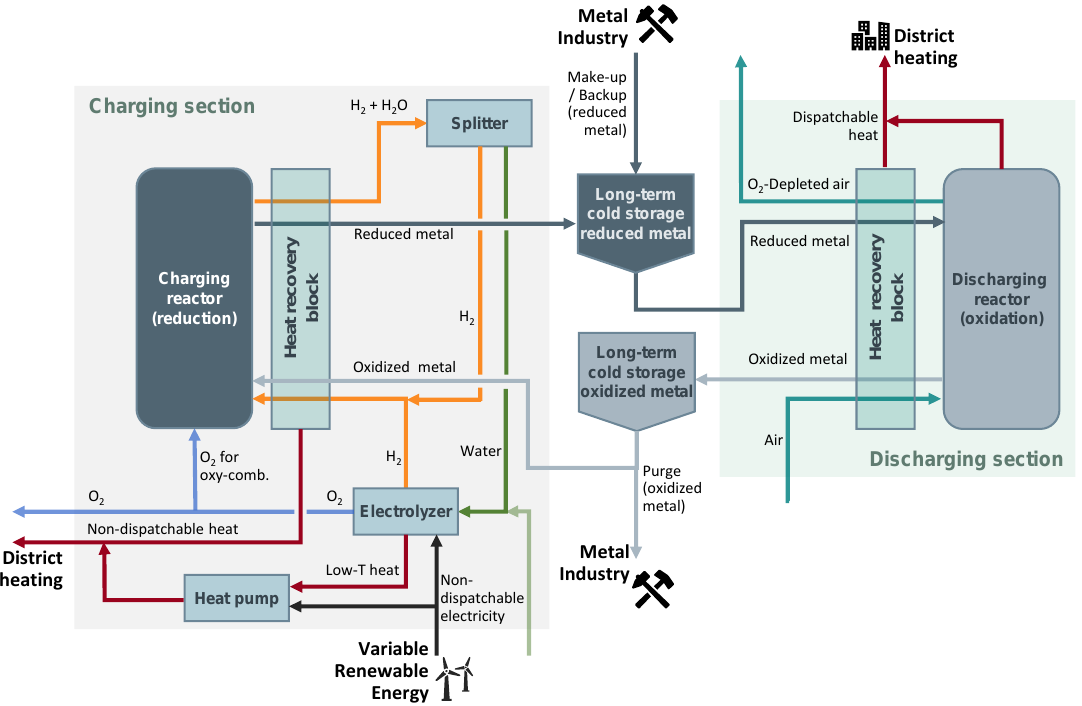
Figure 1. Schematic of the TCES plant proposed in this work, based on a high-temperature redox cycle. The plant absorbs VRE to produce hydrogen in the electrolyzer together with nondispatchable heat for the DH network. The hydrogen is then used to reduce a metal in a charging reactor. From there, the metal is transferred to a storage unit, from which the metal is subsequently transported to a discharging reactor, where it is oxidized to produce dispatchable heat for the DH network. A make-up stream of reduced metal is included, as is the purged oxidized material, which can be sent back to a local metal industry.